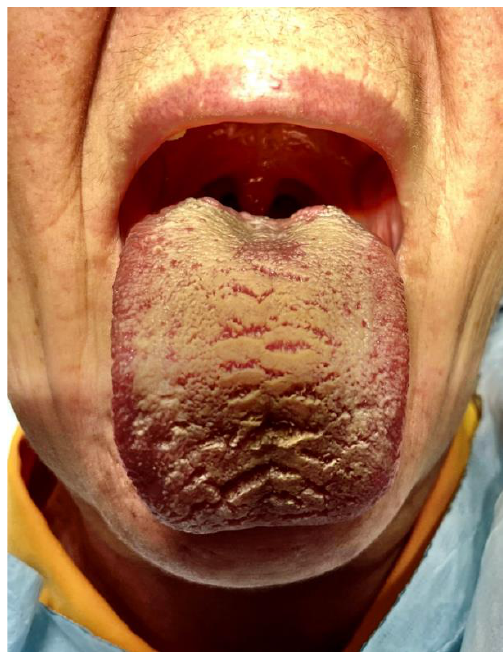
Figure 3. Hyperkeratosis. Figure 4. Recurrent herpes labialis.